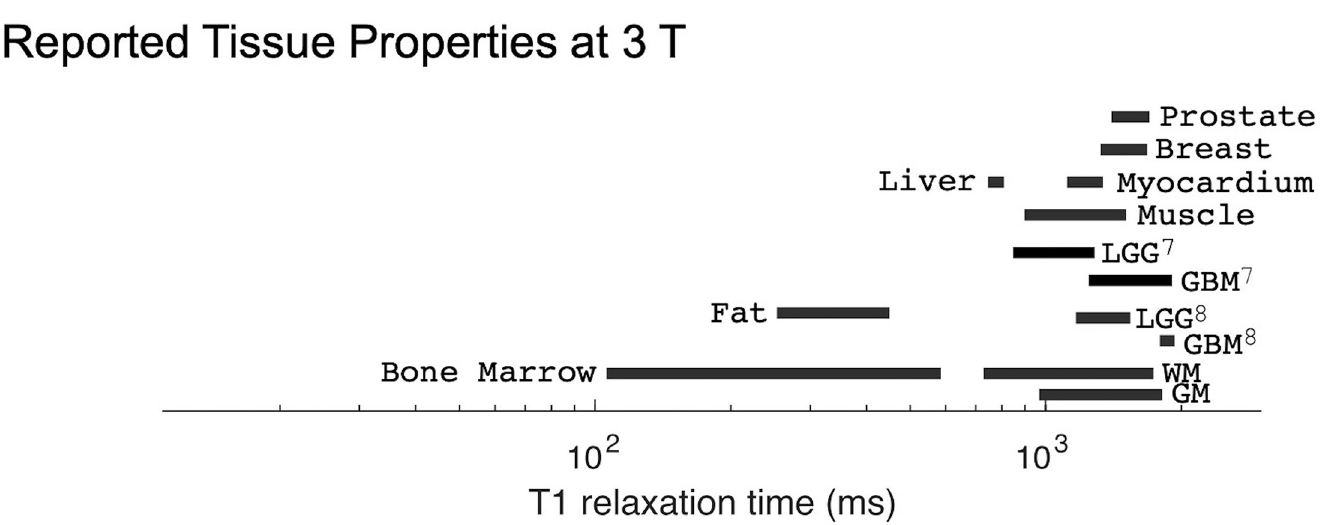
Fig 6. Reported tissue properties at 3 T. Physiological values of normal and diseased tissue from [7–9]. Unless otherwise noted by a superscript, the reference is [9].